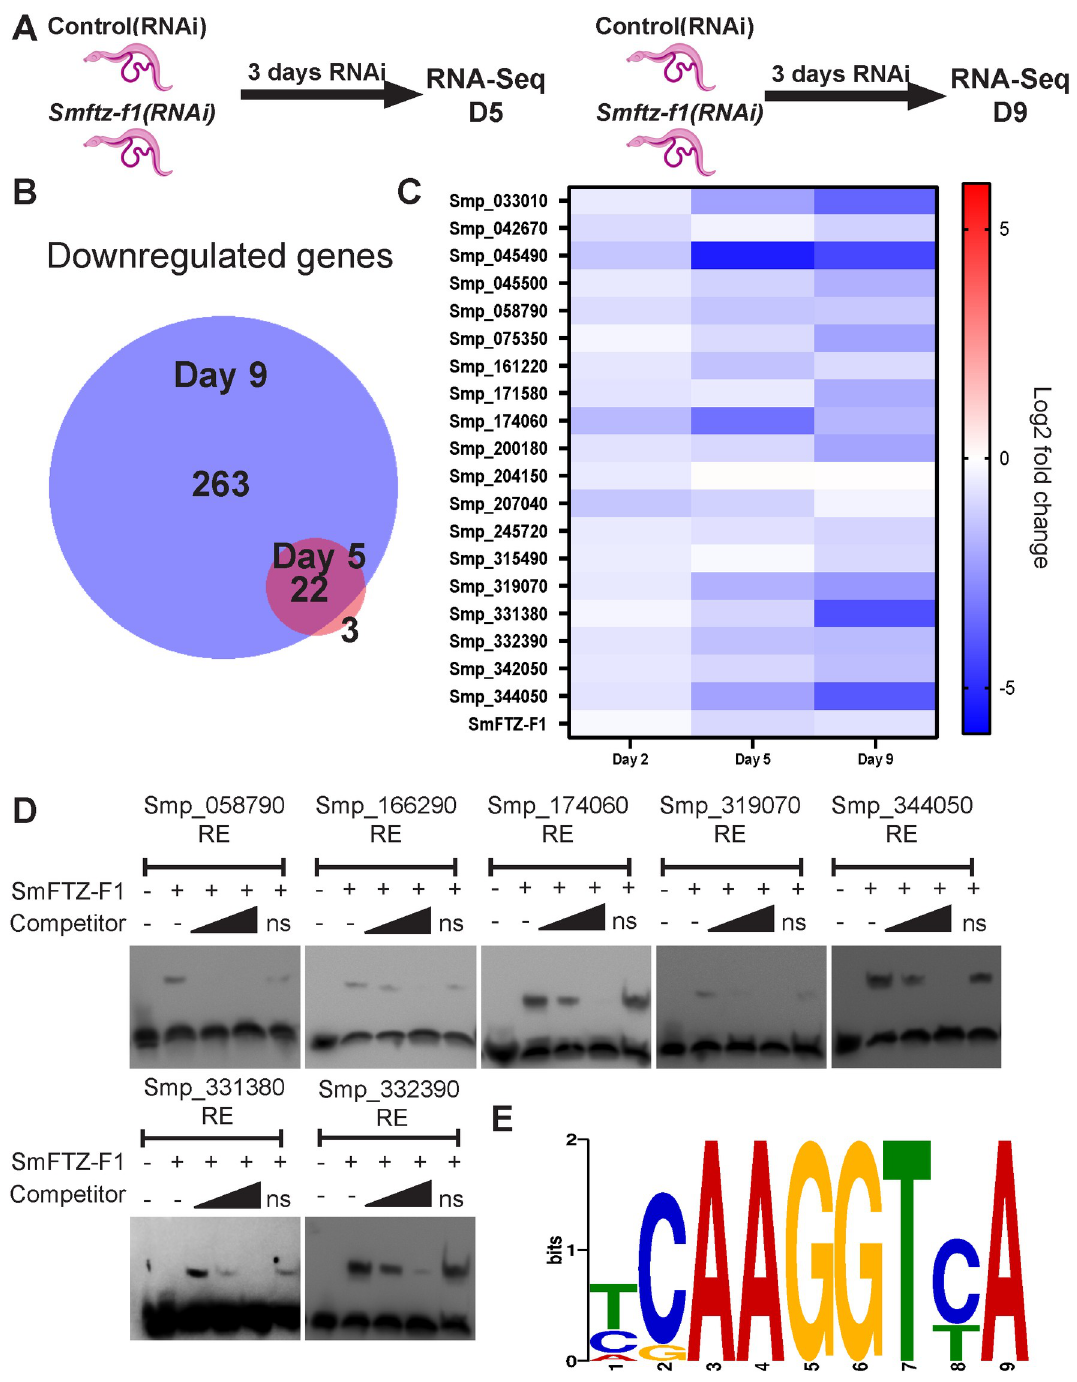
Fig 2. RNAseq reveals possible direct targets of SmFTZ-F1. ( A) Strategy for RNAseq, paired worms were subsequently separated and only male parasites were used. (B) Venn diagram of down-regulated RNAseq gene sets from Day 5 and 9. (C) Heat map of the 20 most differentially down-regulated genes following Smftz-f1 (RNAi) treatment. n = 10 worms , 3 biological replicates. (D) Micrographs of EMSAs using biotin-labeled oligonucleotides corresponding to each of the candidate SmFTZ-F1 response elements. EMSAs were performed in presence or absence of in vitro translated SmFTZ-F1 protein ± the presence of 20-fold or 200-fold direct unlabeled competitor oligonucleotides. ns, non-specific oligo at 200-fold excess. n = 2 biological replicates. (E) Predicted DNA-binding motif sequence for nuclear receptor SmFTZ-F1. The height of the letter represents how frequently that nucleotide is observed in that position. The logo was generated using the MEME Suite.